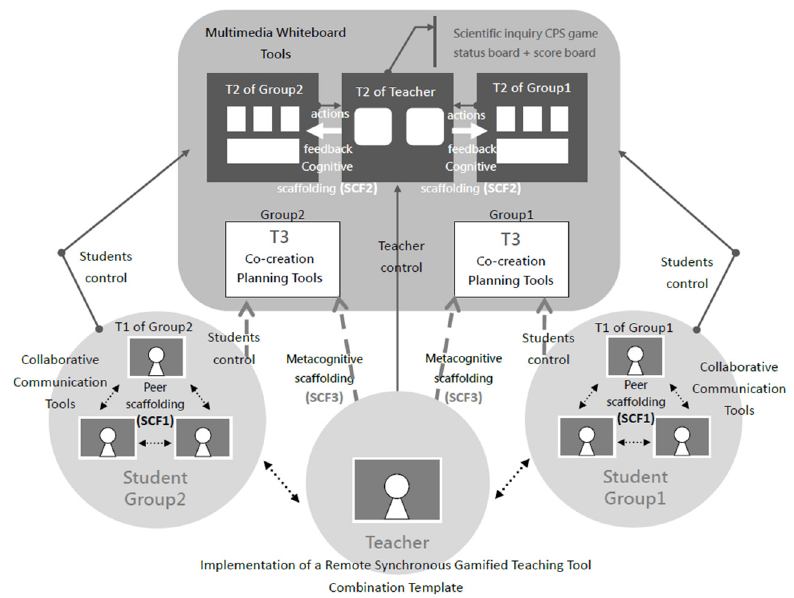
Figure 2. Implementation of a Remote Synchronous Gamified Teaching Tool Combination Tem- plate.